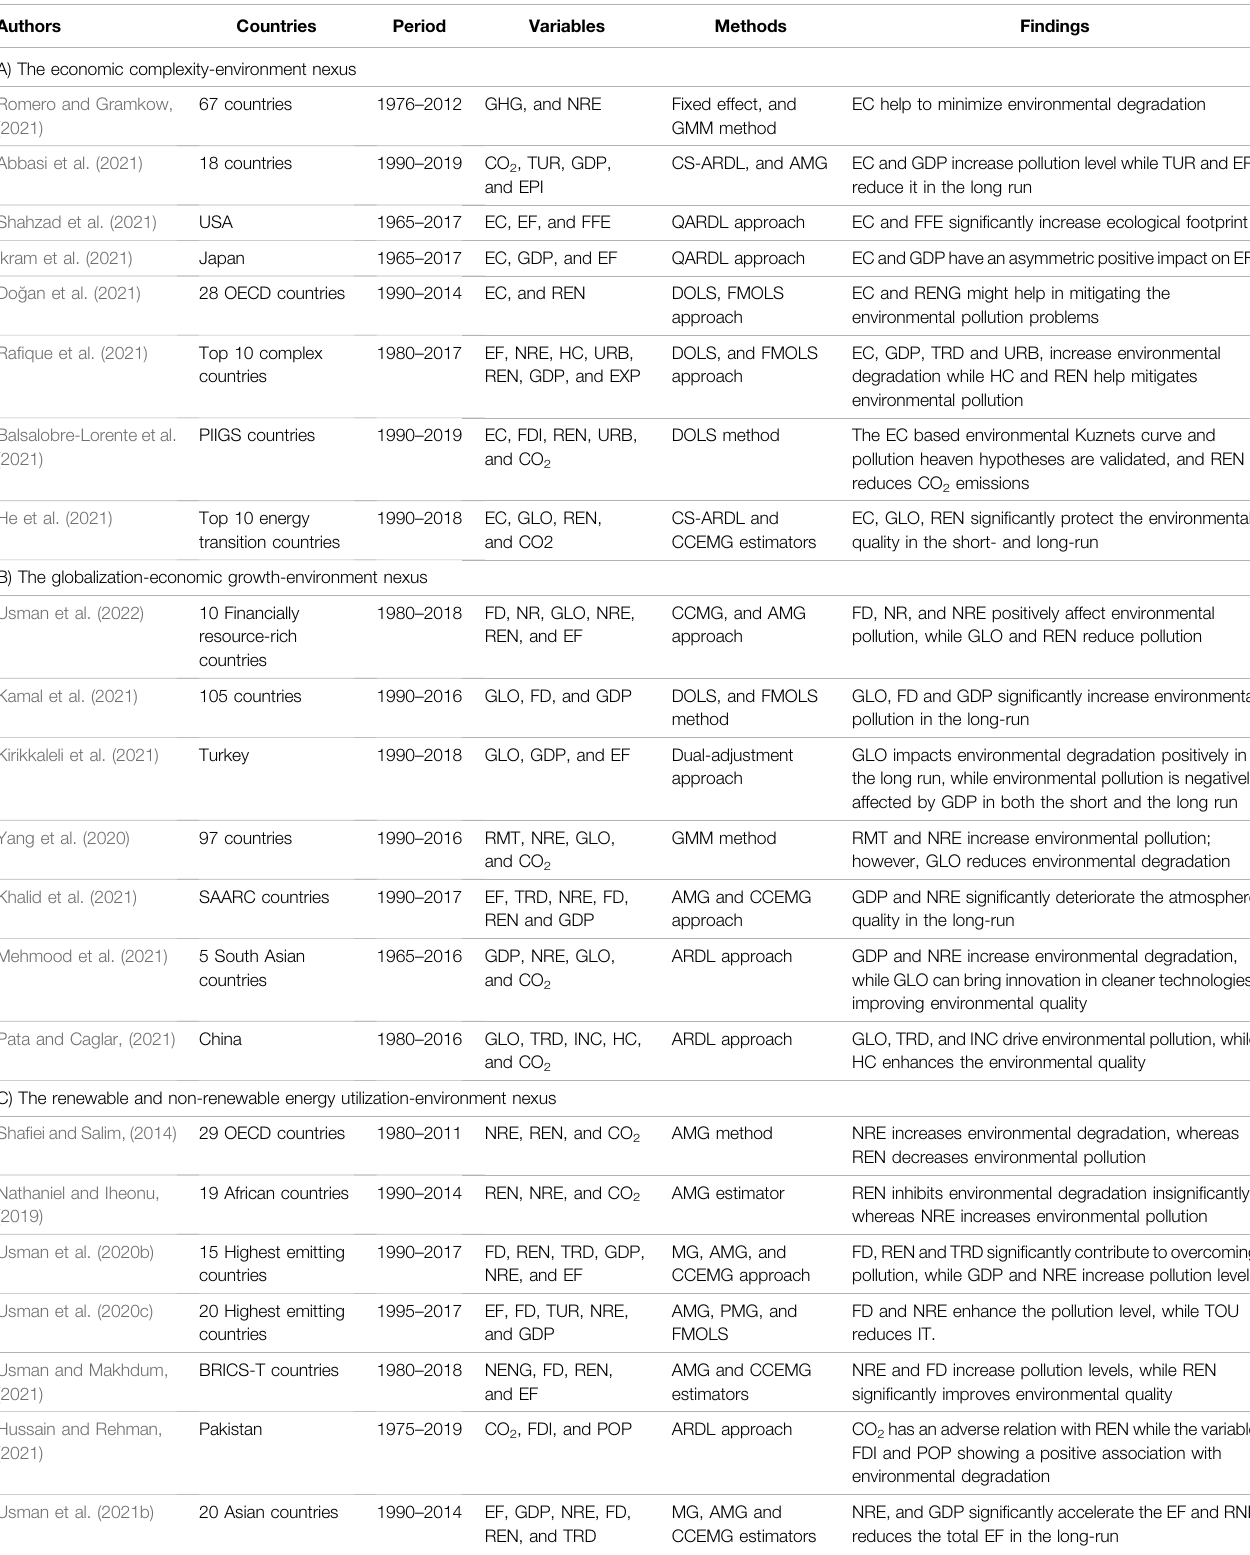
TABLE 1 | Summary of the published literatures between EC, NRE, RNE, GLO, GDP-environment